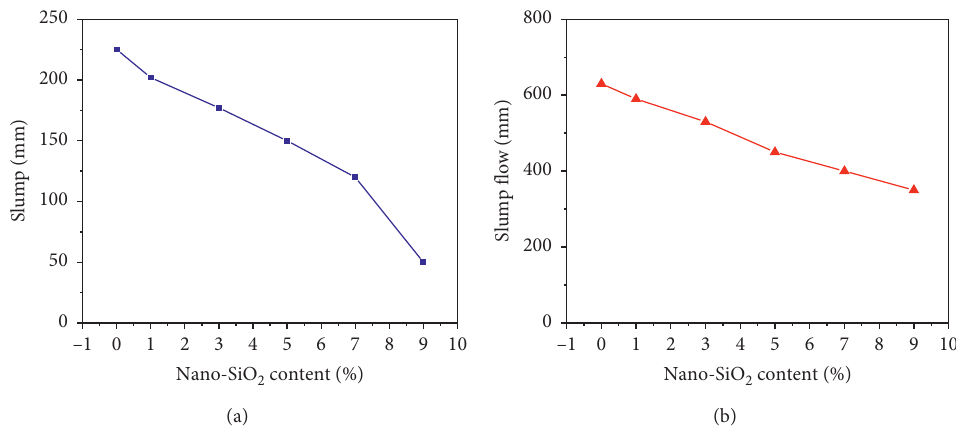
Figure 3: Effect of NS content on the (a) slump and (b) slump flow [51].